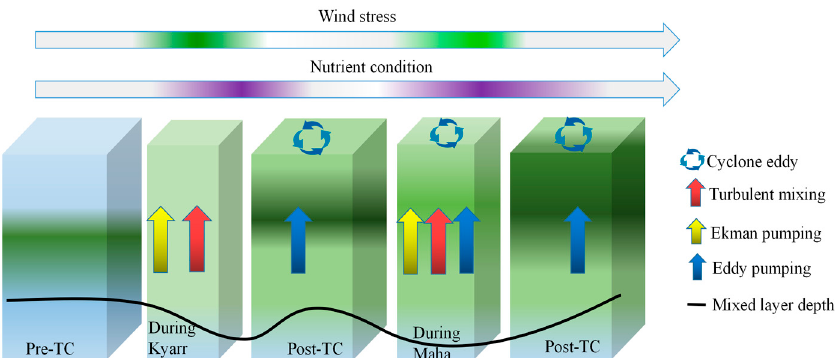
Figure 13. A schematic sketch of the upper ocean biological response (vertical chl-a) to sequential TC events. TC